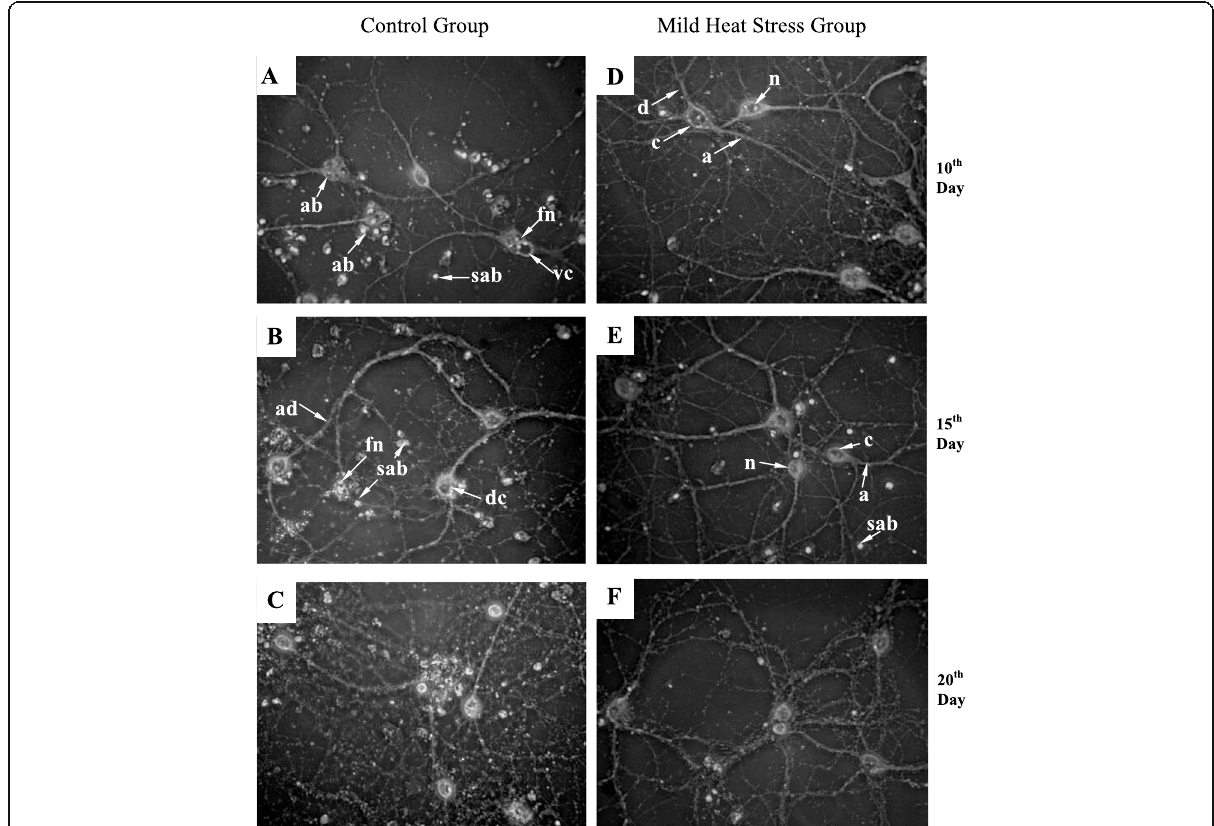
Fig. 3 Effect of mild heat stress on the morphological alterations in the primary culture of mouse prefrontal cerebrocortical neurons undergoing senescence in vitro. Fragmented nuclei (fn), apoptotic body (ab), suspended apoptotic body (sab), vacuolated cyton (vc), dendrites (d), cyton (c), nucleus (n), axon (a), axonal degeneration (ad), degenerating cyton